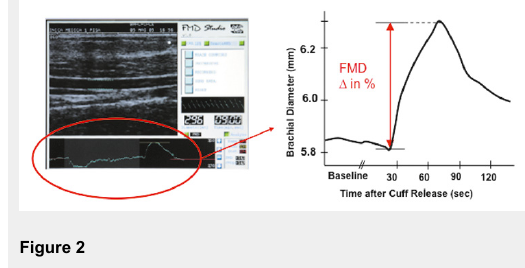
Flow-mediated vasodilatation. Example of a typical ultrasound image of the brachial artery is demonstrated. Arterial diameter is shown schematically at baseline and after reactive hyperaemia induced flow-mediated vasodilatation. Blood pressure cuffs can be placed on the upper or the lower side of the transducer in the antecubital fossa, although the latter is the preferred method. On the right hand side, the time course of an FMD measurement is shown. See text for further